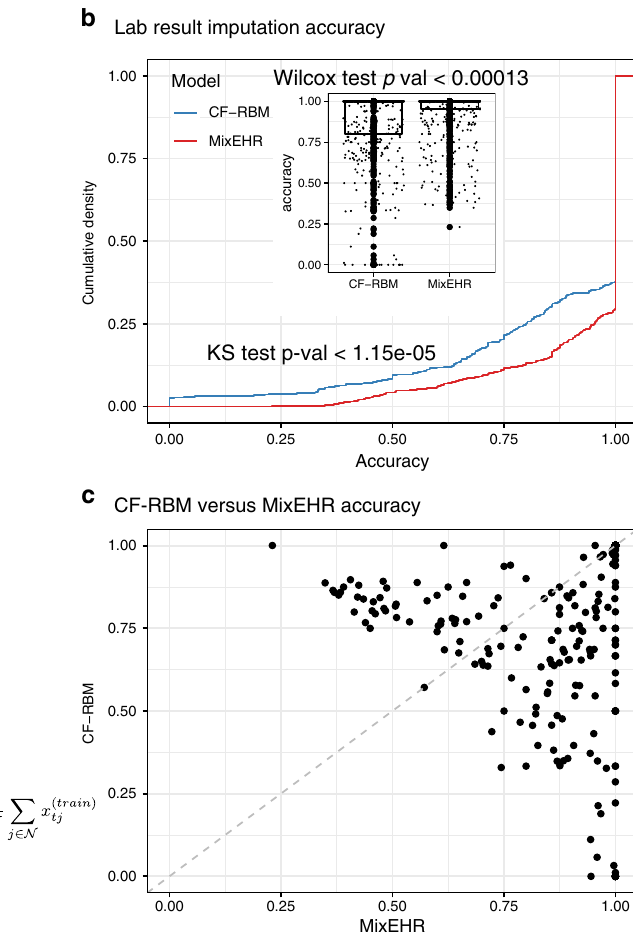
Fig. 7 Lab results imputation using MIMIC-III dataset. a Work fl ow to impute lab results. Step 1: We modeled lab tests, lab test results, and non-lab EHR data (i.e., ICD, notes, prescription, treatment) to infer the patient topic mixture. Step 2: For a test patient, we masked each of his observed lab test result t , and inferred his topic mixture. Step 3: We then found k = 25 patients who have the lab test results t observed and exhibit the most similar topic mixture to the test patient. We then took the average of lab result values over the k patients as the prediction of the lab result value for the test patient j 0 . Steps 1 – 3 were repeated to evaluate every observed lab test in every test patient. b We compared the imputation accuracy between MixEHR and CF- RBM. We generated the cumulative density function (CDF) of accuracy as well as the boxplot distributions (inset) for each method. The center line, bounds, and whiskers of the boxplots are median, fi rst and third quartiles, and outlier, respectively. In both cases, MixEHR signi fi cantly outperformed CF-RBM based on KS test ( p < 1.15e-5) and Wilcoxon signed-rank one-sided test ( p < 0.00013). c CF-RBM versus MixEHR scatterplot in terms of imputation